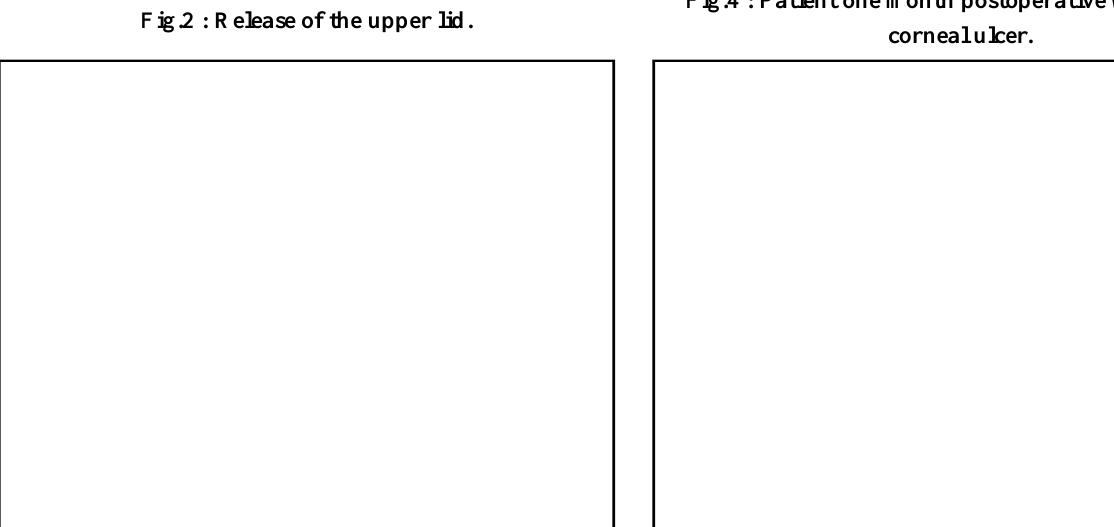
Fig.3 : Full thickness skin grafting with medial tarsor- rhaphy.